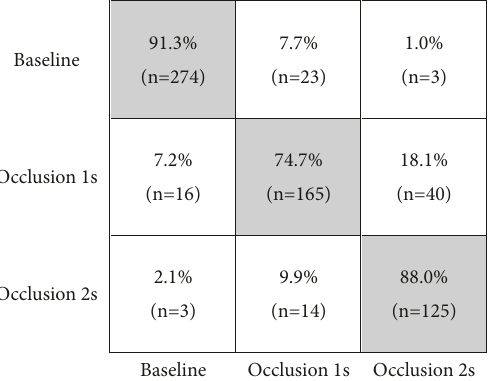
Figure 6: Confusion matrices of eyes-off-road durations predic- tion models using combination of glance location and duration